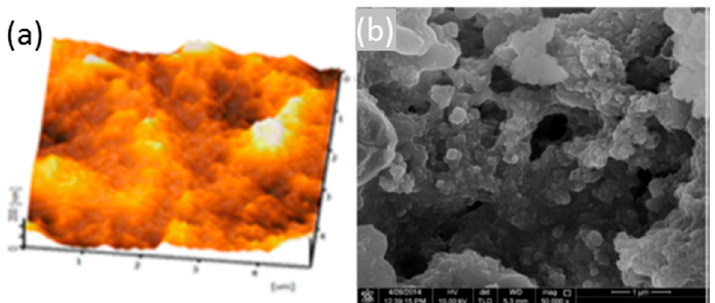
Figure 21. Sol gel coatings prepared with a mixture of SiO 2 and TiO 2 : ( a ) AFM image of the coating doped with a pH indicator and ( b ) a SEM image to highlight the porous structure of the layer. Reprinted from [95] with permission of